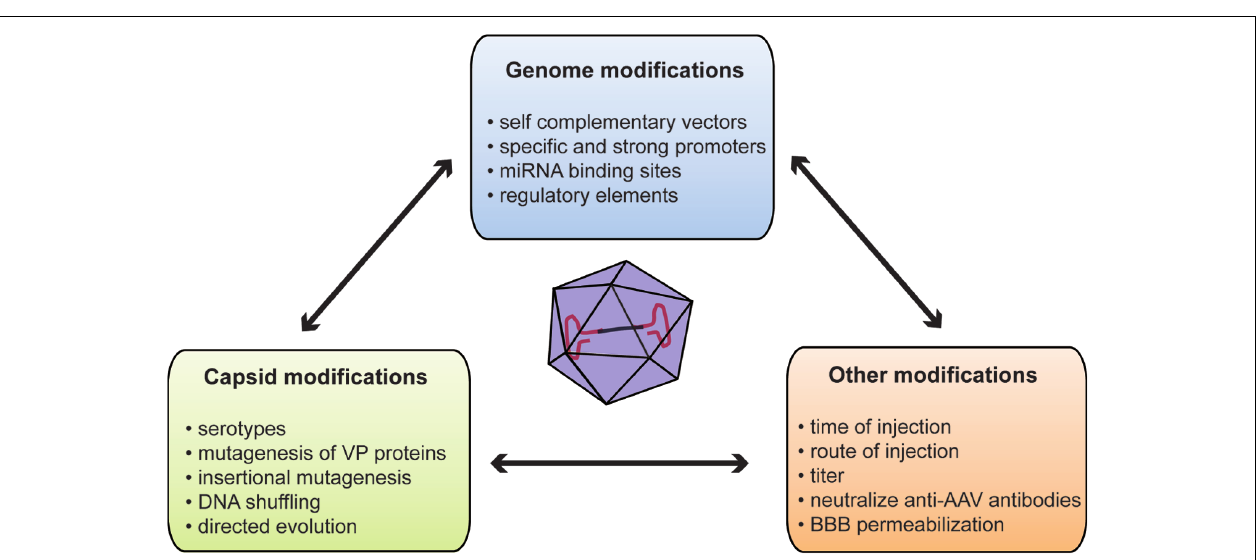
FIGURE 1 | Summary of methods used to improve gene delivery after systemic injection ofAAVs. AAV, adeno-associated virus; BBB, blood–brain barrier; miRNA, microRNA;VP, viral particle protein.